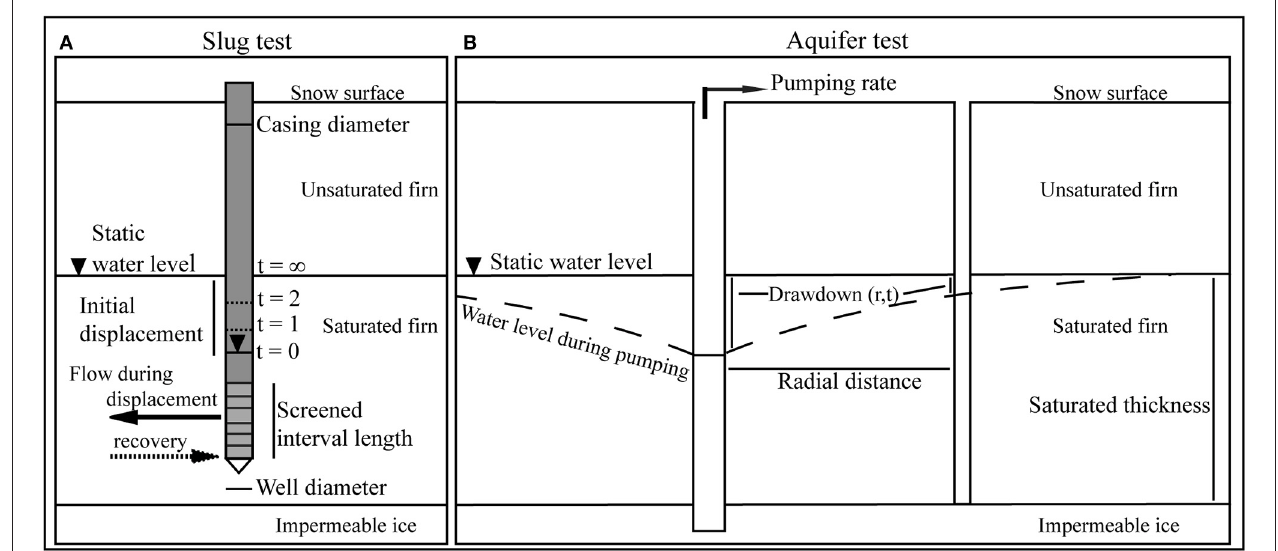
FIGURE 3 | Diagrams of slug and aquifer tests. The aquifer and well geometry for slug (A) and aquifer (B) tests used in analysis of slug and aquifer tests.